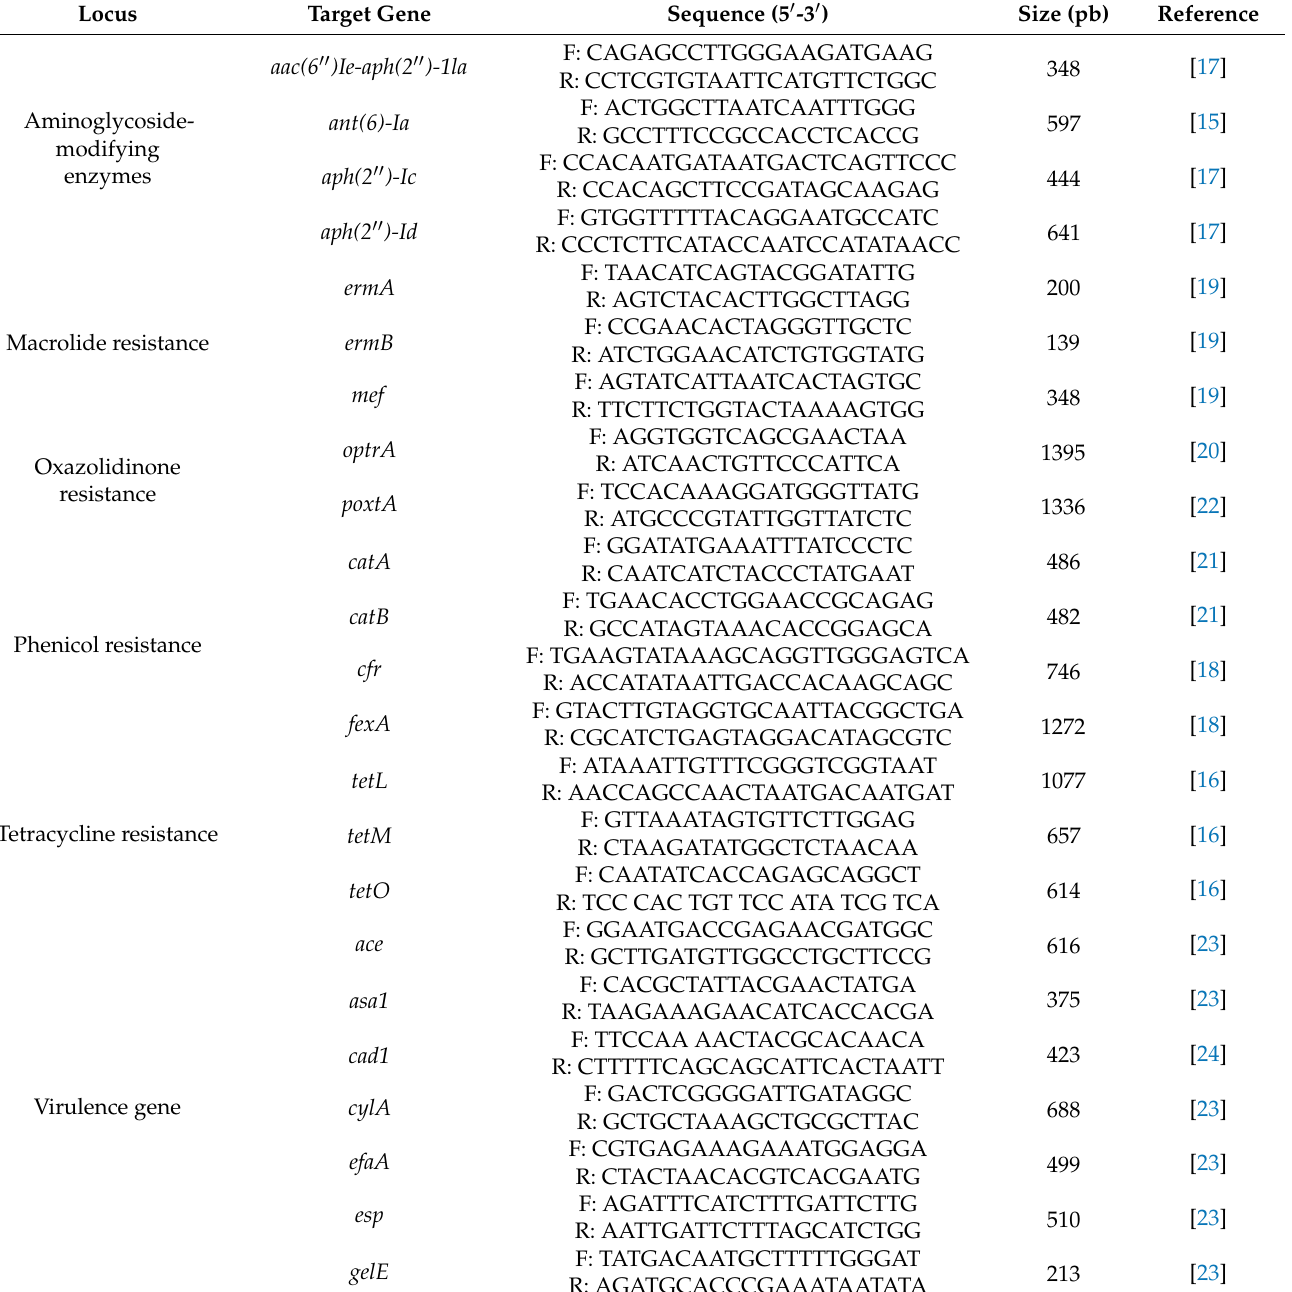
Table 1. Primer sequences used for this